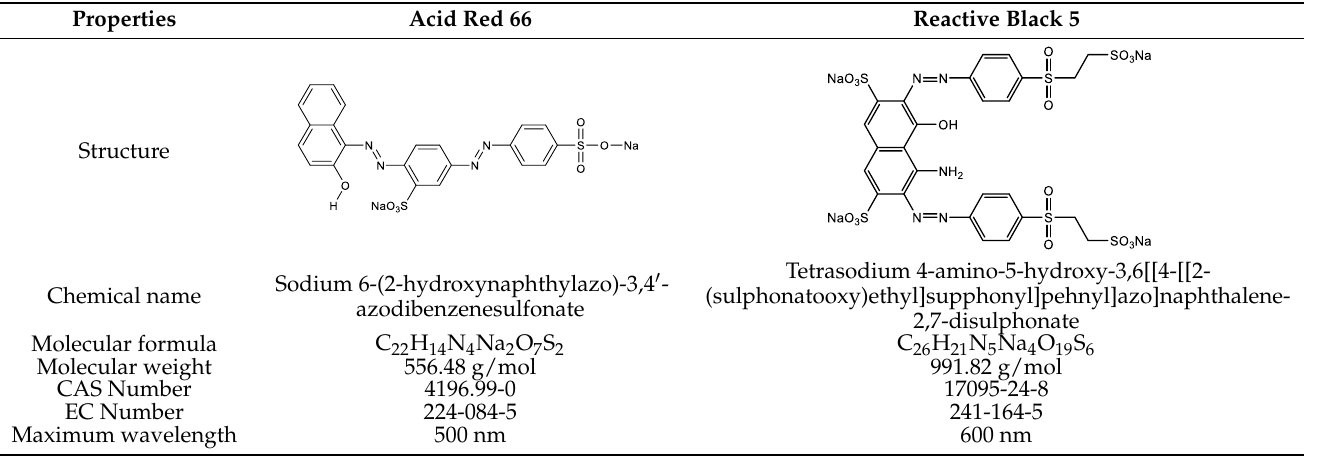
Table 7. Model azo dyes properties.